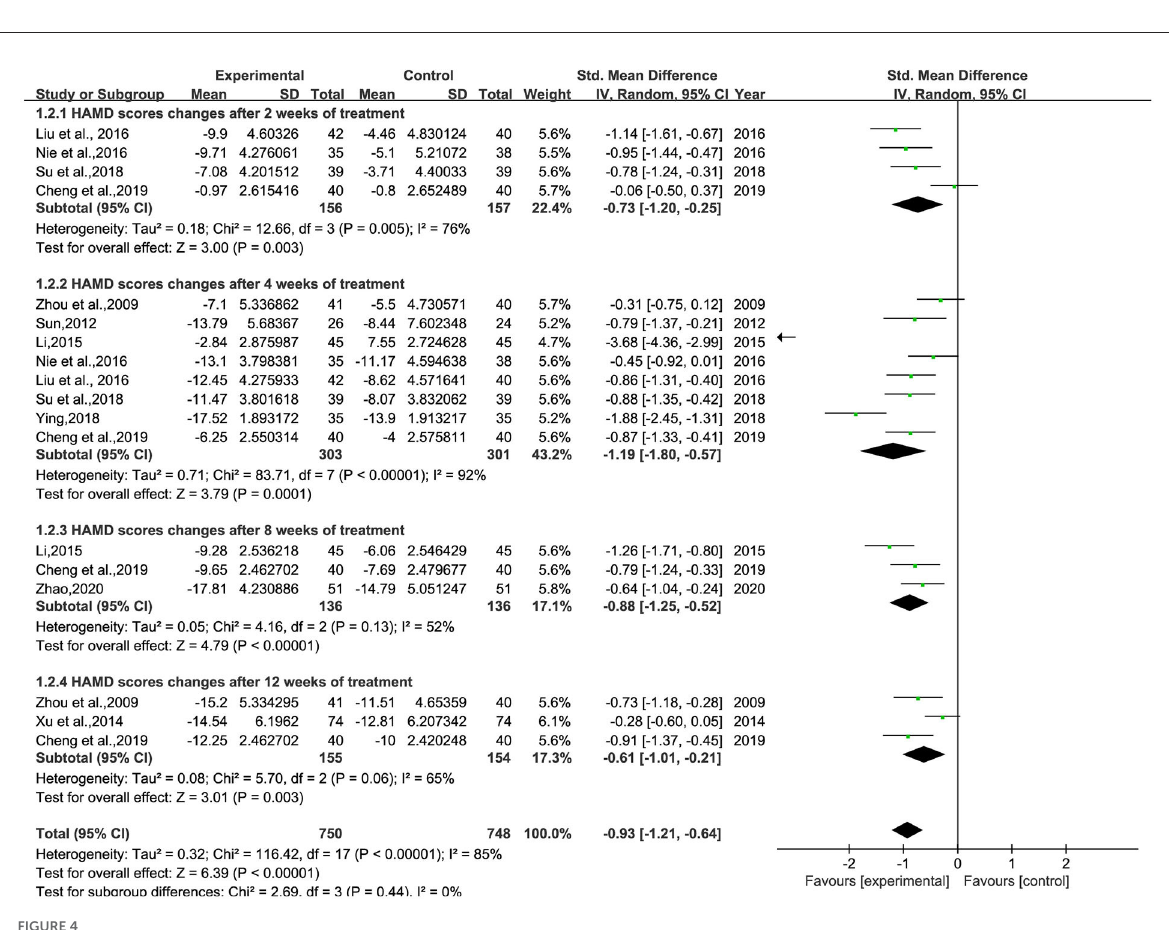
the most obvious after 4 weeks of BHD administration. The reason of heterogeneity may be related to the different types of antidepressants and the standard of the HAMD